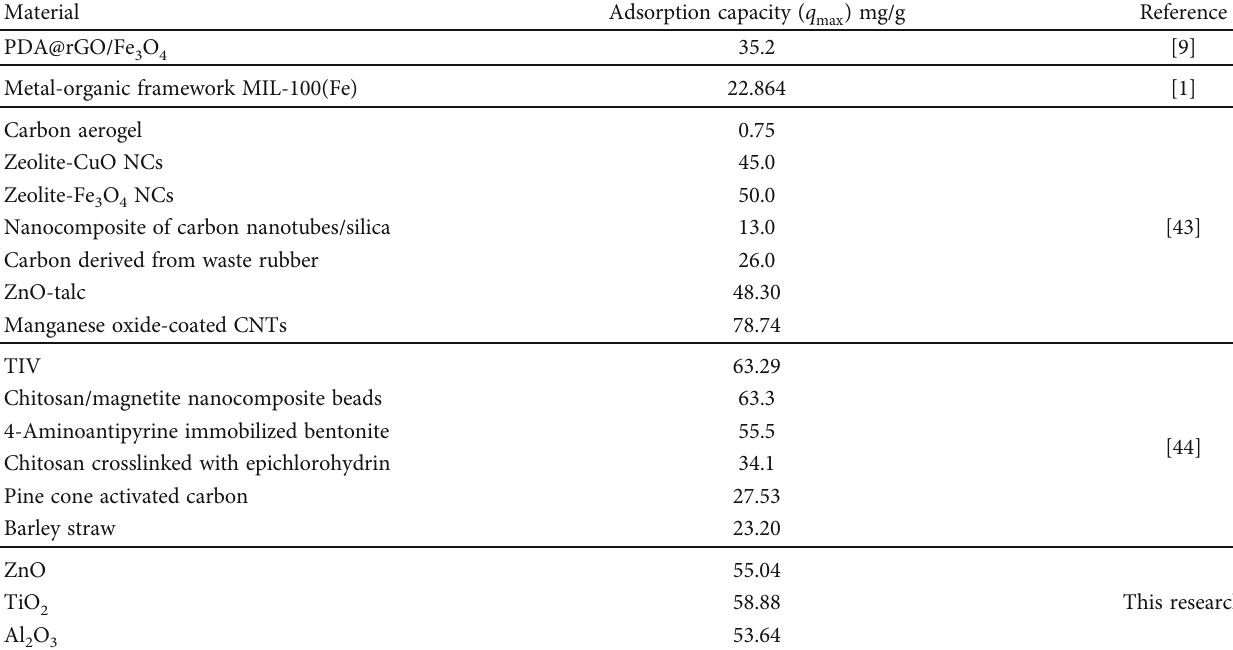
Table 3: Comparison of the adsorption capacities of Pb(II) using various